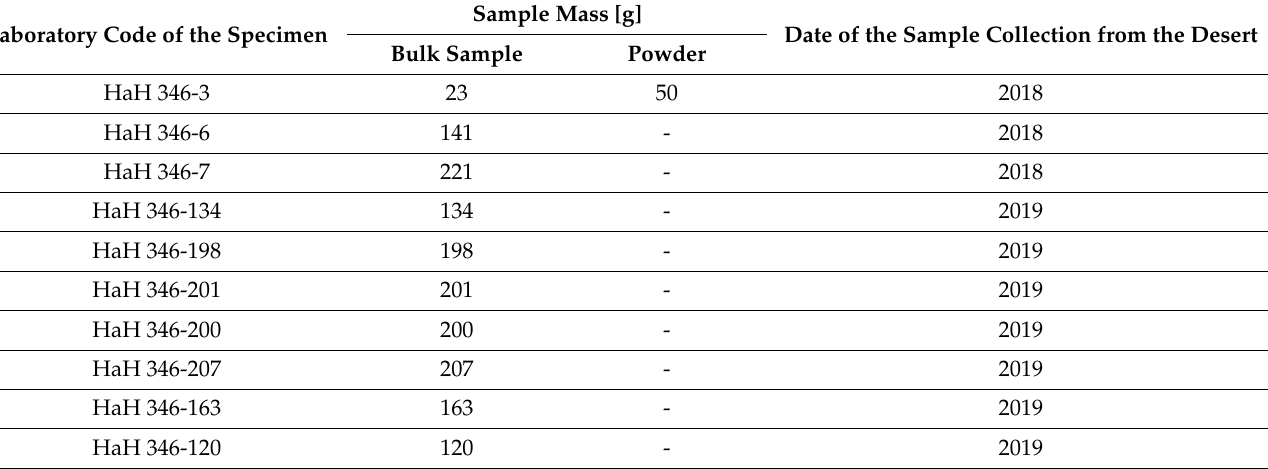
Table 1. List of the